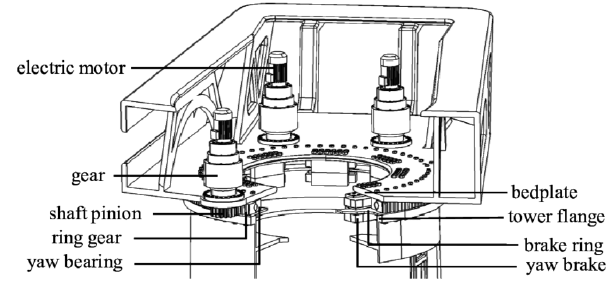
Figure 1. Wind turbine yaw system. Reproduced from Kim and Dalhoff (2014).